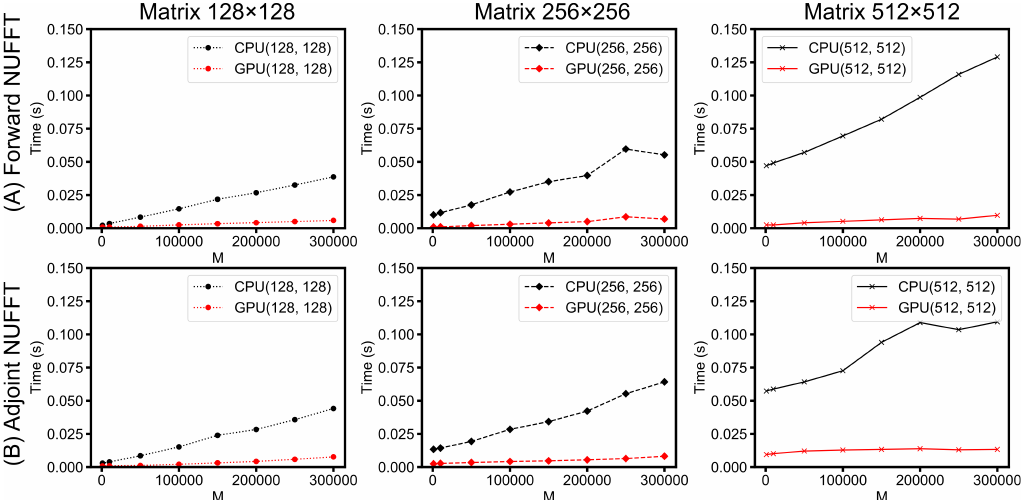
Figure 13. Runtimes versus the number of non-uniform locations (M) for different matrix sizes. ( A ) Forward NUFFT; ( B ) Adjoint NUFFT. The system was equipped with a CPU (Intel Core i7 6700HQ at 3500 MHz, 16 GB system memory) and a GPU (NVIDIA GeForce GTX 965 m, 945 MHz, 2 GB device